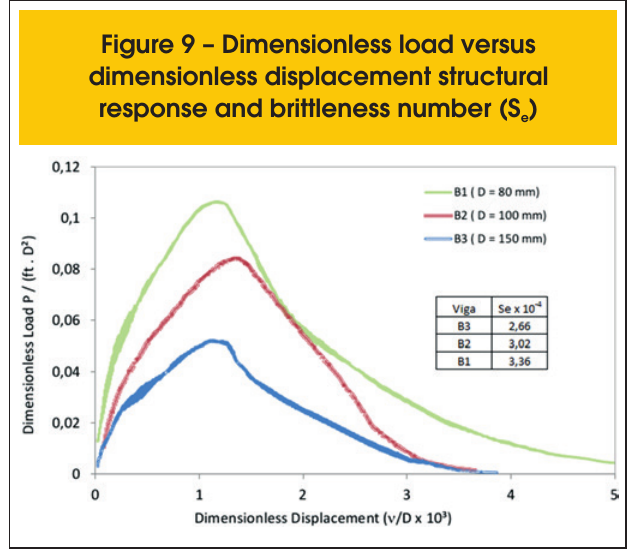
Figure 9 – Dimensionless load versus dimensionless displacement structural